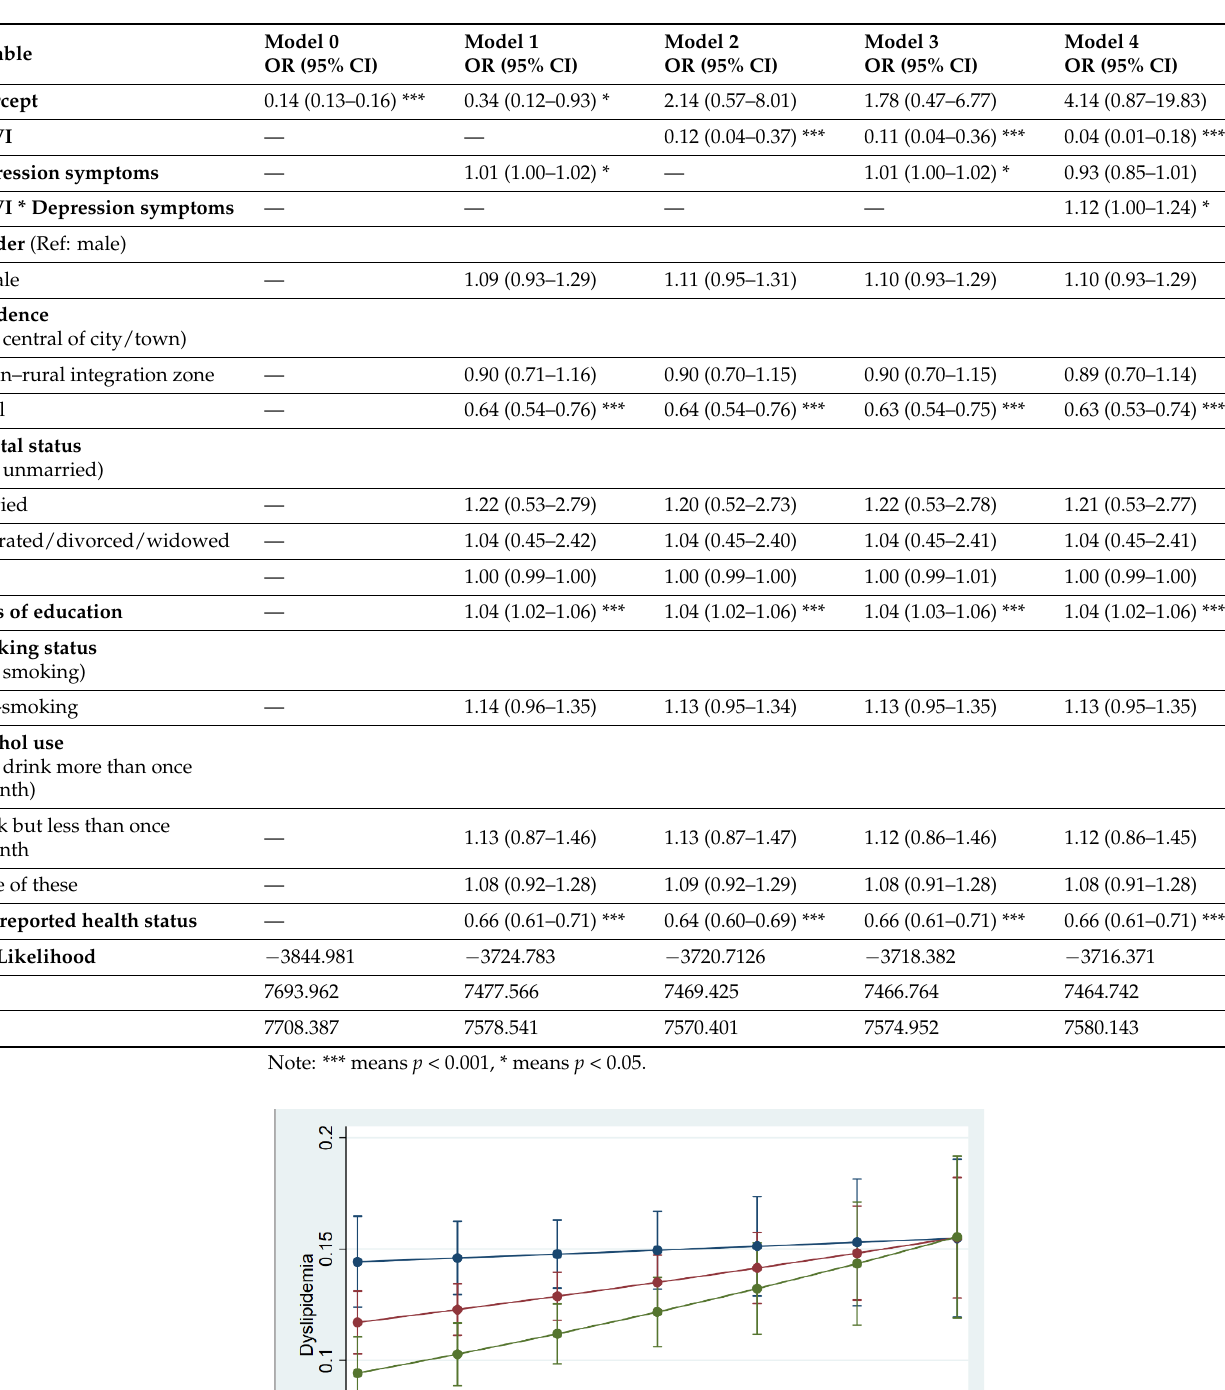
Table 3. Multilevel logistic regression (N = 10,022).